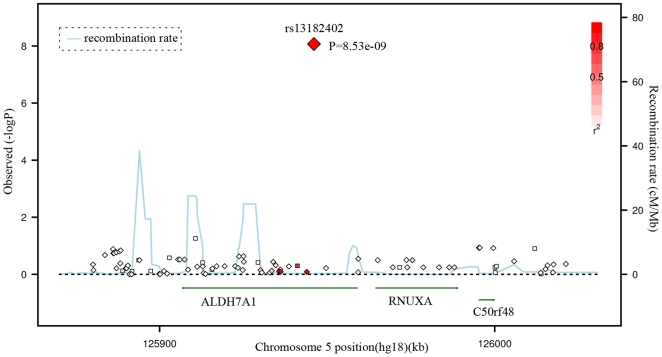
Regional Association Plot for rs13182402 on chromosome 5 in the GWAS stage.The color scheme of a white-to-red gradient reflects lower to higher LD values (r2). The scatter graph indicates the negative logarithm of P-value for each SNP.